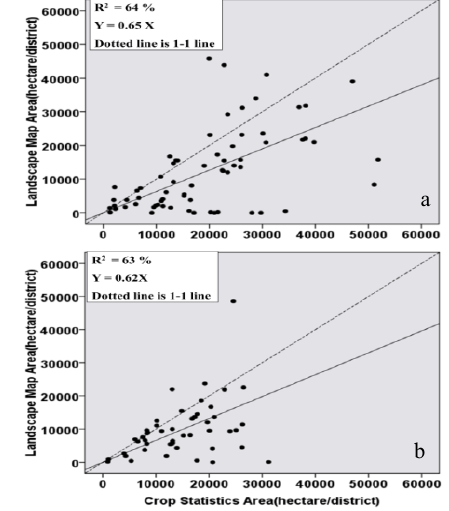
Figure 9. Scatter plots showing two rice crop (a) and three rice crop (b) areas of the Landscape-ecological map versus crop sta-